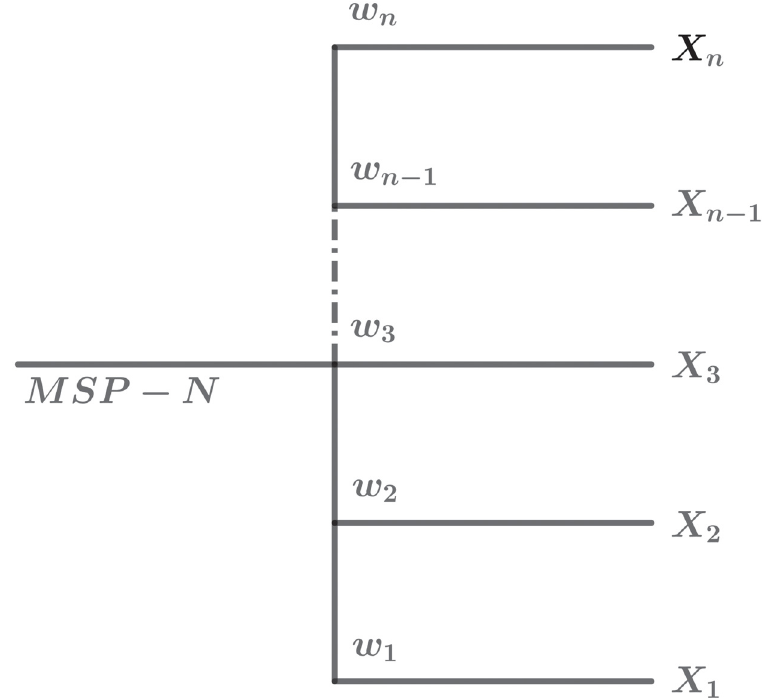
Fig 1. Graphical representation of Multiple-Selection-Procedure (MSP-N). Each incoming node can choose one out of N mechanisms for link formation.